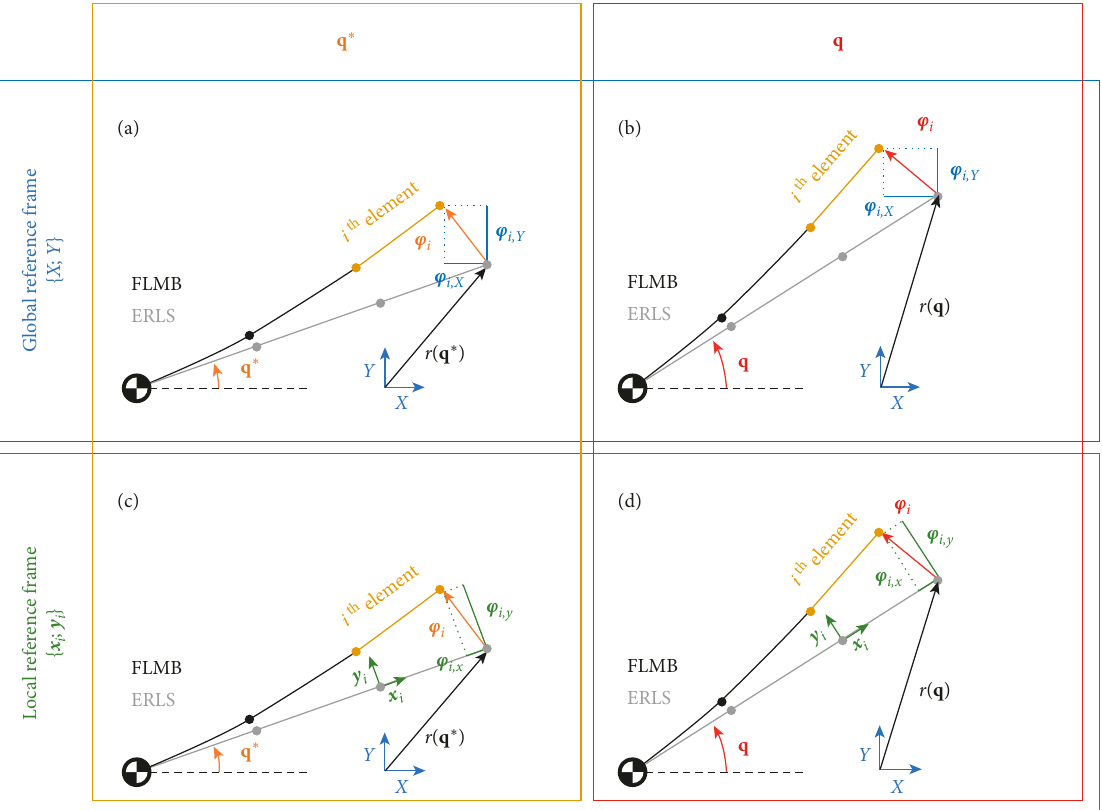
Figure 1: Example of eigenvector components in a planar flexible single link for two ERLS configurations: q to the global reference frame (a-b) and the local reference frame